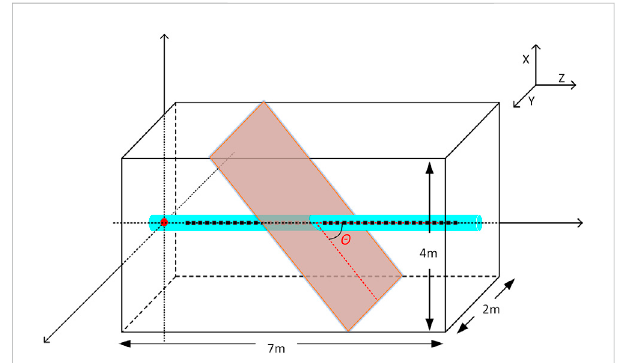
FIGURE 1 Schematic diagram of three-dimensional model of an in fi nite extent fracture intersected with horizontal well in tight reservoirs.